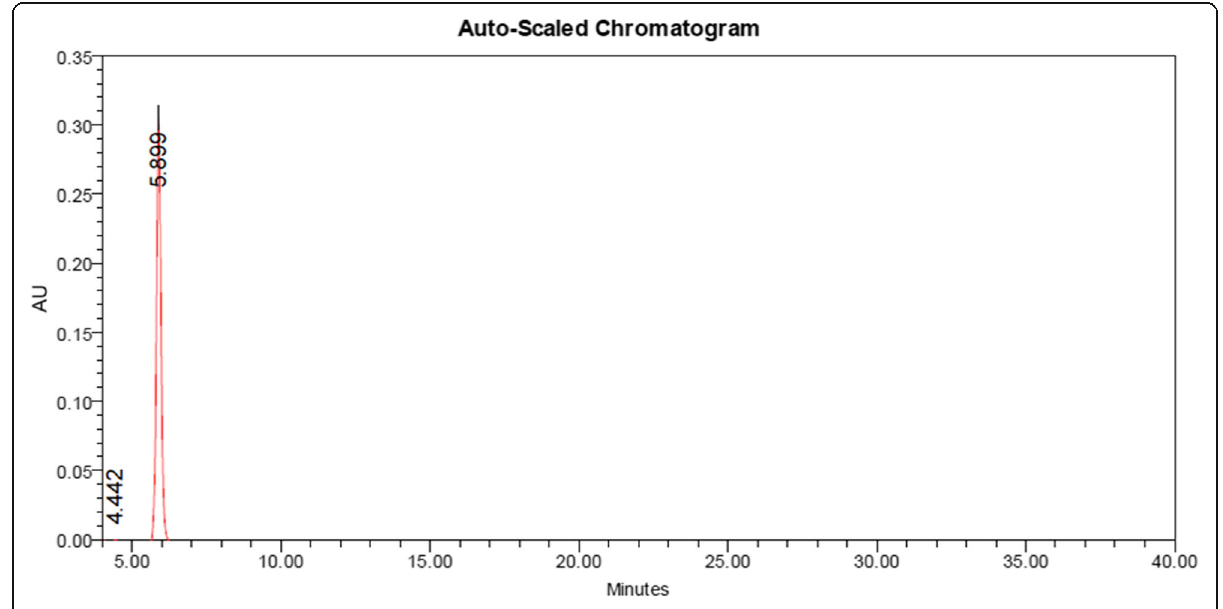
Fig. 2 HPLC chromatogram obtained by analysis of standard injection of